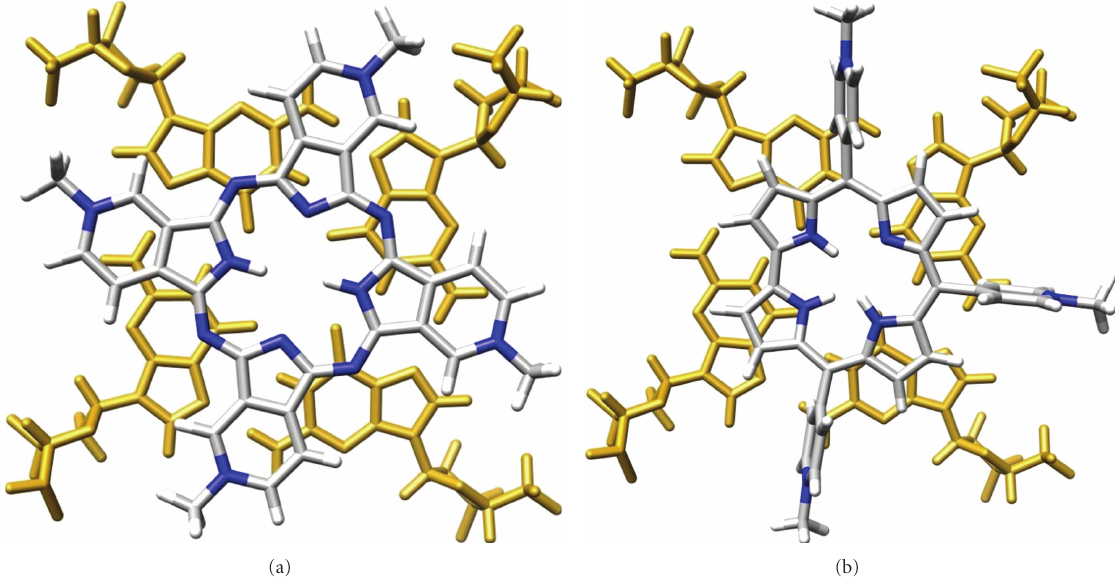
Figure 10: Qualitative in silico superposition of 3,4-TMPyPz (a) and corrole (b) and a G-tetrad (extracted from PDB entry: 2A5R); guanine residues appear in gold; the carbon, nitrogen, oxygen, and hydrogen atoms of the ligands in grey, blue, red, and white,